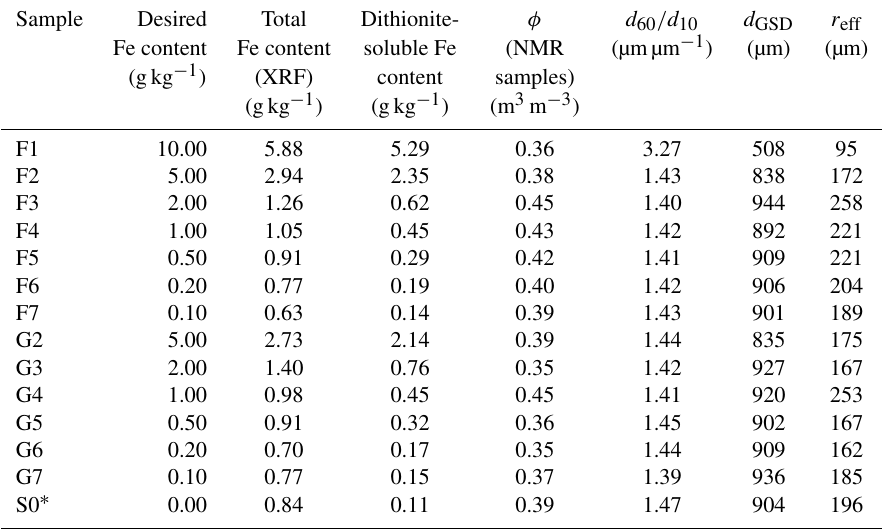
Table 1. List of samples with synthetic ferrihydrite (F) and goethite (G) coating (Set A). Sample Desired